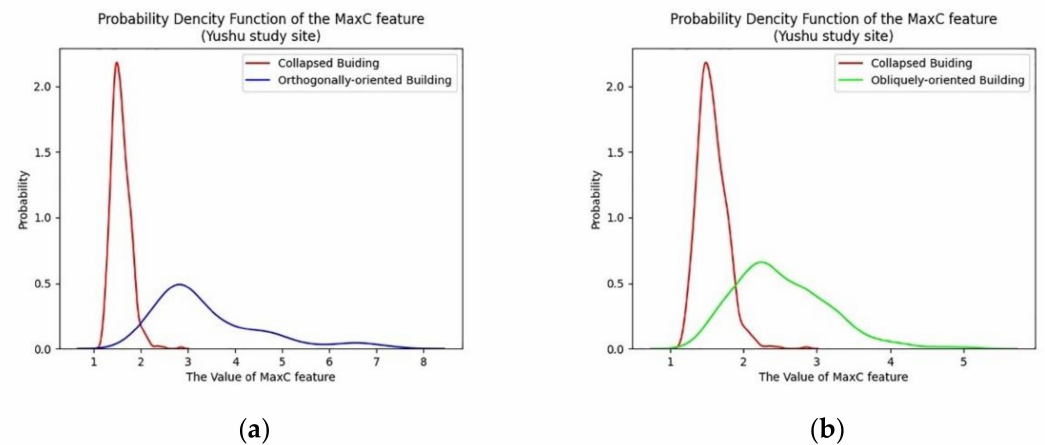
Figure 21. The pdfs of the MaxC feature in the Yushu study site: ( a ) pdfs of collapsed buildings and orthogonally-oriented buildings; ( b ) pdfs of collapsed buildings and obliquely-oriented buildings.